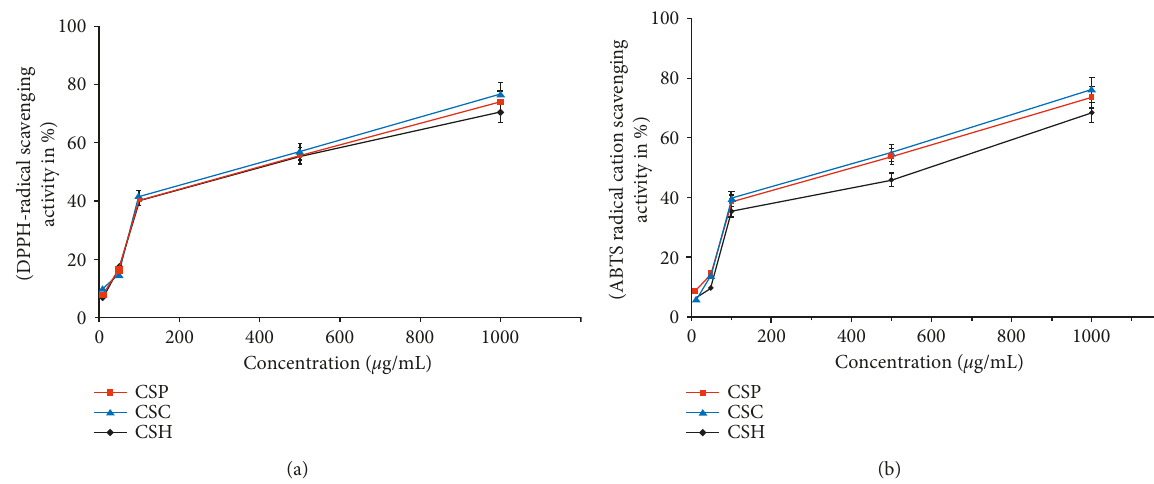
Figure 6: Antioxidant activities of (a) CSP � C. scolymus L. petal, (b) CSC � C. scolymus L. choke, and (c) CSH � C. scolymus L. heart, (a) DPPH scavenging activity; (b) ABTS scavenging activity. Data results are presented as means ± standard deviation (SD).